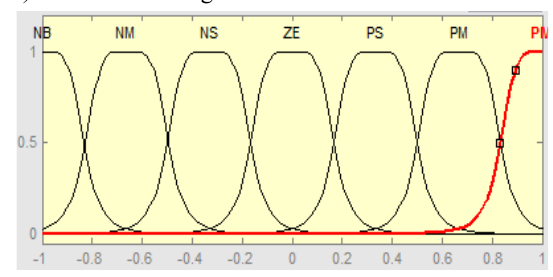
Figure 5. Membership functions of the input variables Fuzzy output variable